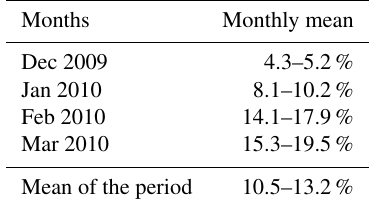
Table 3. Monthly discharge from Universidad Glacier as a percent- age of the total discharge in the Tinguiririca River, measured at the DGA station. Ranges in the percentages are for F DH ice values